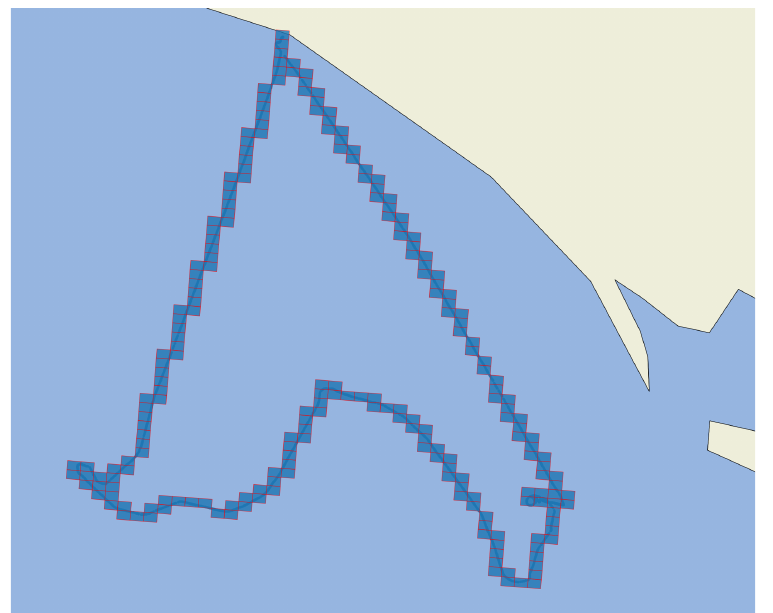
Figure 9. Discretization example from a vessel trip, from the inferred binary-search tree grid